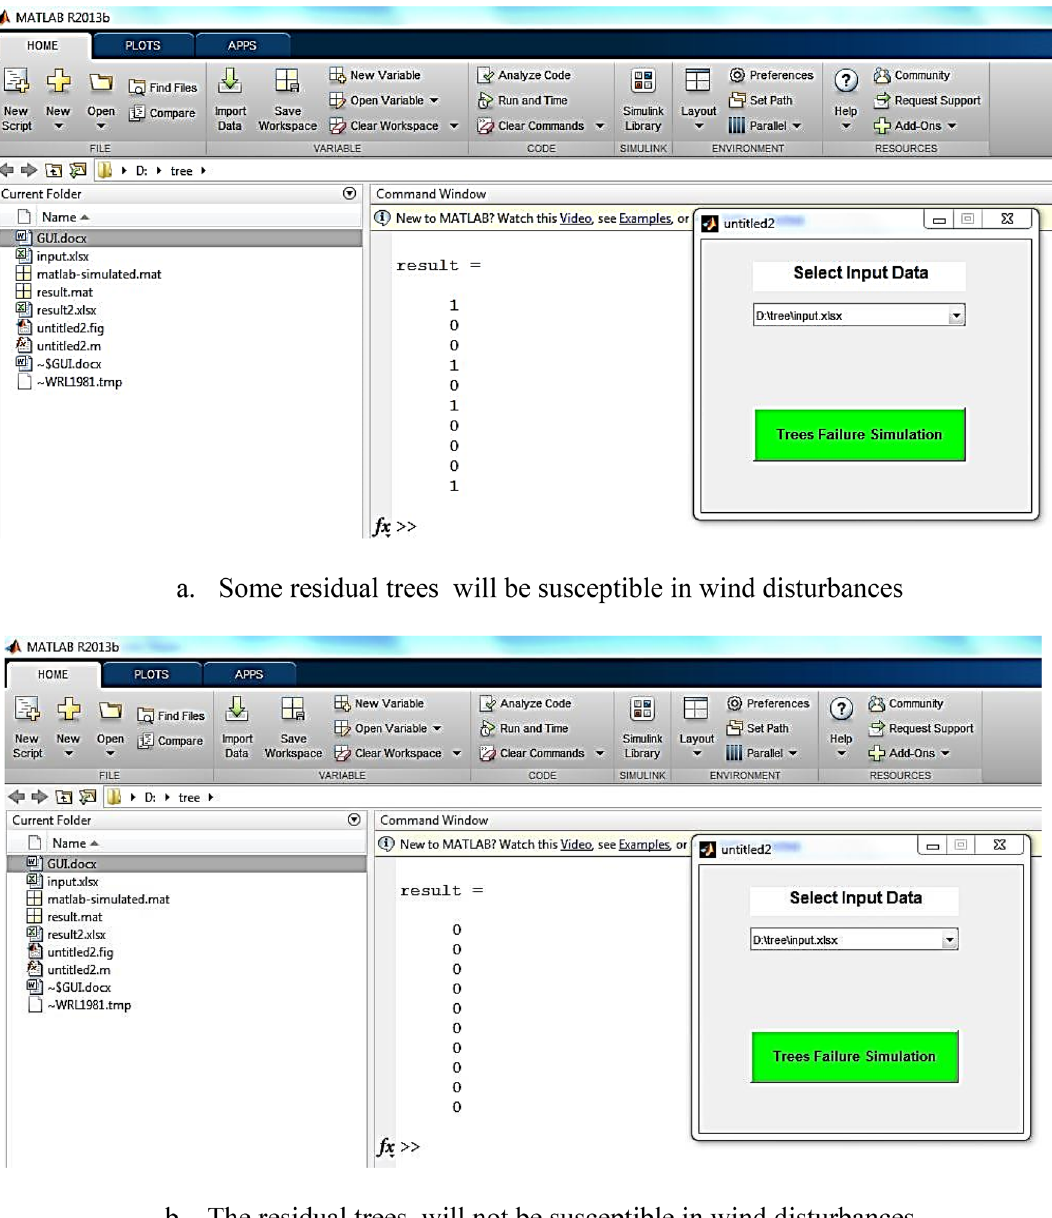
Figure 9. A snapshot of the Graphical User Interface of the Decision Tool for two cases with different plot characteristics (including trees Mean Height (MH), trees Density (De), Tree Crown Diameter (TCD), Tree Height (TH), Minimum Distance from Neighbor trees (MiDN), Number of Thicker trees (than the target tree) (NTh), Mean Distance from Neighbor trees (MeDN), Tree Area (TA), Soil Depth (SD), trees Mean Diameter at the Breast Height (MDBH), Maximum Distance from Neighbor trees (MaDN), Tree Diameter at the Breast Height (TDBH), Number of Taller trees (NTa), trees Diversity (Di) and Plot Slope